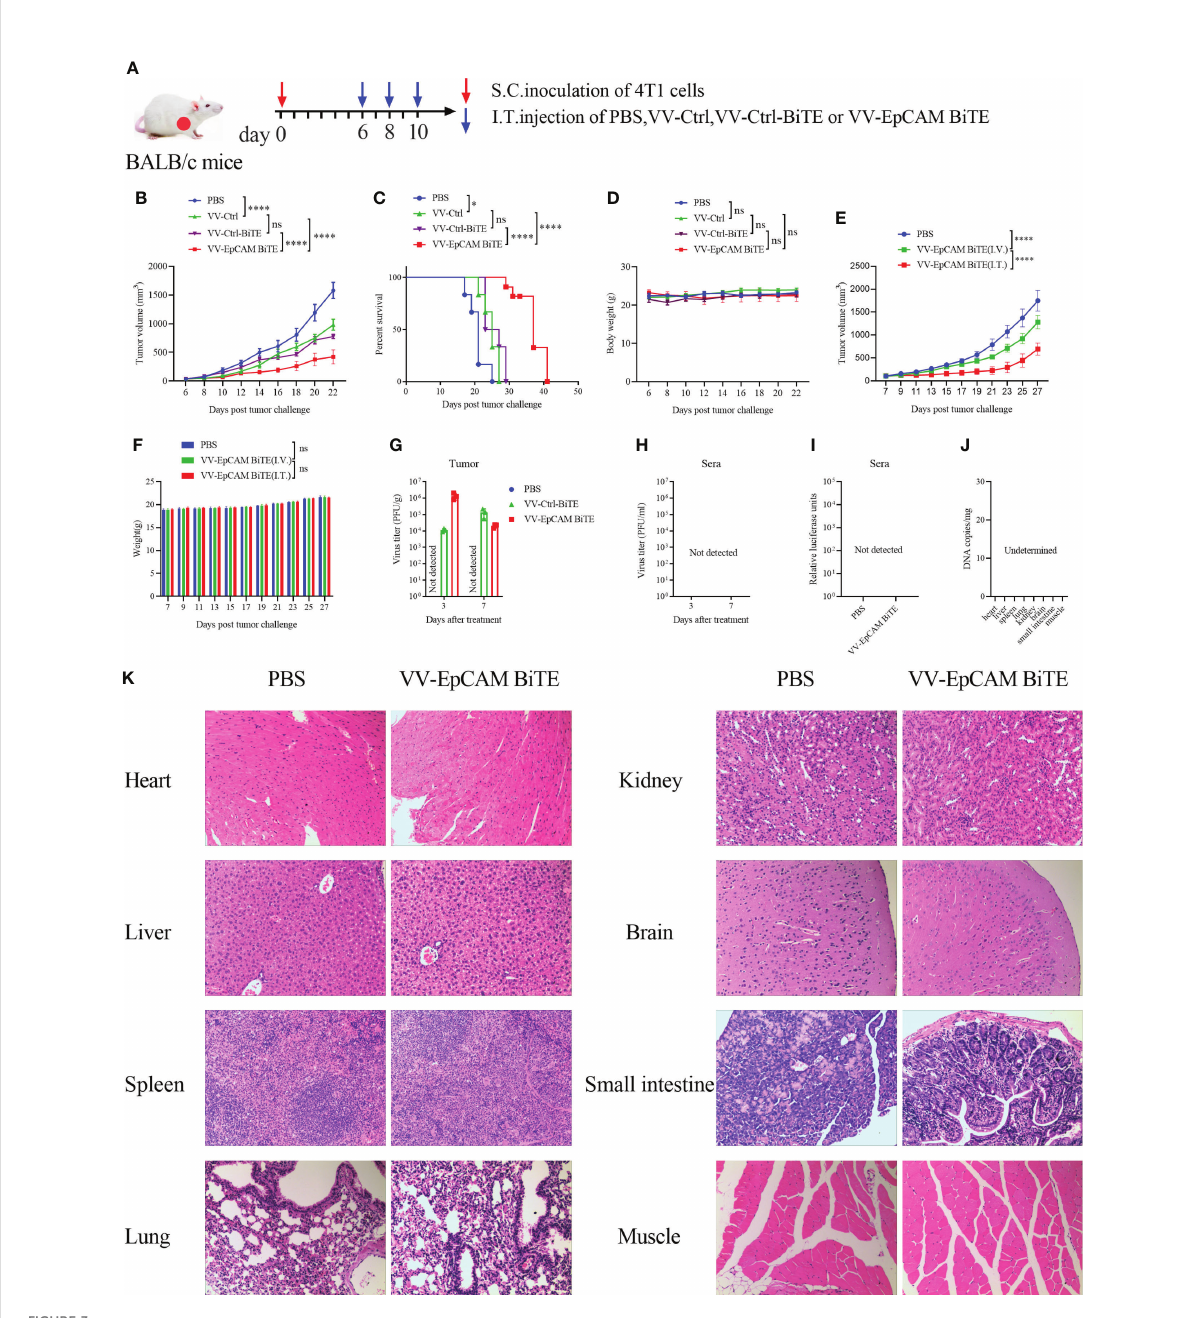
FIGURE 3 Antitumor effect of VV-EpCAM BiTE in the 4T1 model. (A) Experimental timeline for 4T1 models. BALB/c mice were subcutaneously inoculated with 2x10 5 4T1 cells. 6 days later, tumor-burdened mice were intratumorally injected with PBS or VVs at a dose of 1x10 7 PFU per mouse 3 times. (B) The volumes of tumor were monitored by caliper measurement. Data are presented as means±SEM. (C) Kaplan-Meier survival curves of 4T1-bearing mice. (D) Body weight of 4T1-bearing mice. (E) Tumor volume of mice injected VV-EpCAM BiTE. I.V, intravenous injection; I.T, intratumoral injection. Data are presented as means±SD. (F) Body weight of mice injected with VV-EpCAM BiTE. (G, H) Replication of VVs in the tumor tissue and sera was detected by titration assays. (I) The EpCAM BiTE levels in blood. Sera